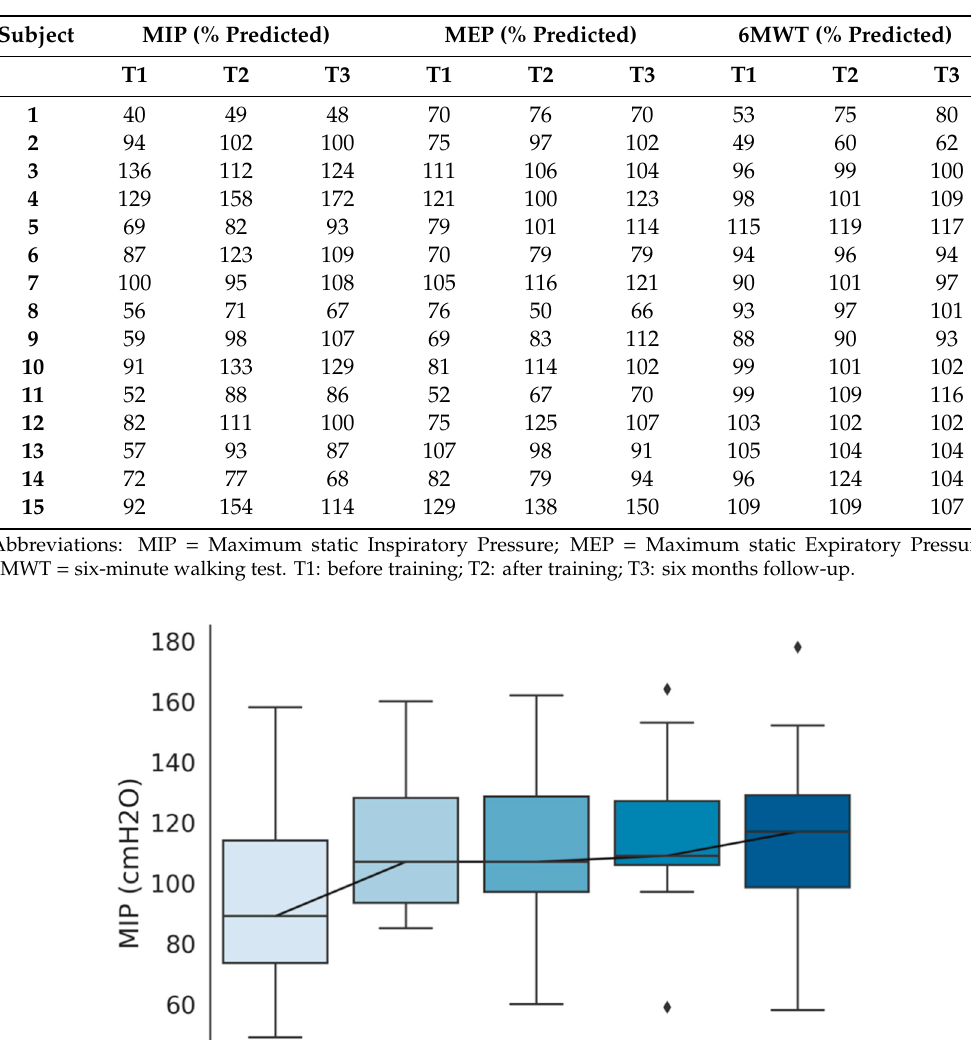
Table 2. Percentage of predicted MIP, MEP, and 6MWT distance of every subject measured before, after, and six months after completion of the training program.